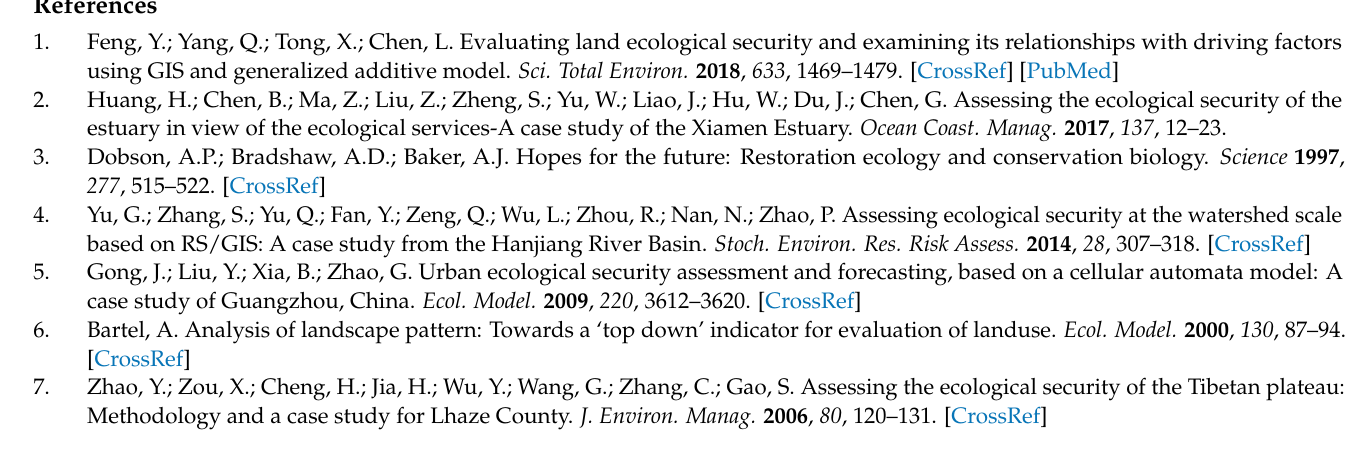
Figure A2. Spatial distribution of the ecosystem services demand in 1990 and 2015 in the Pearl River